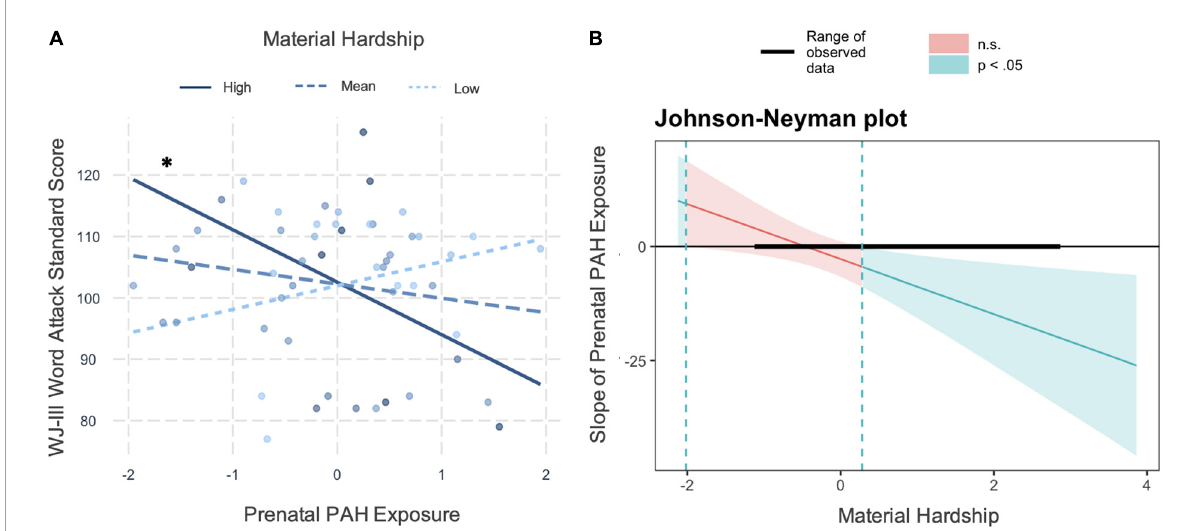
FIGURE2 Interaction plot showing prenatal PAH by material hardship predicting WJ-III Word Attack standard scores. (A) The prenatal PAH by material hardship interaction associated with lower Word Attack standard scores at age 7. Higher PAH associated with lower Word Attack standard scores at higher levels of material hardship (mean ± 1SD), ∗ p < 0.05. (B) Johnson–Neyman plot showing the slope of the association between prenatal PAH and Word Attack standard scores at age 7 ( y -axis). PAH was z-scored here ( M = –0.05, SD = 0.90) so that the slope can be interpreted as a 1 SD increase in PAH is associated with an Y unit increase in Word Attack values. The observed range of material hardship values was –1.10, 2.83 which is noted in black by the y = 0 line. The region of significance analysis indicates a p < 0.05 significant association between prenatal PAH exposure and Word Attack standard scores in the shaded blue region, (no significant associations in the red, at values of material hardship between –2.02, 0.28). ∗ represents a significant